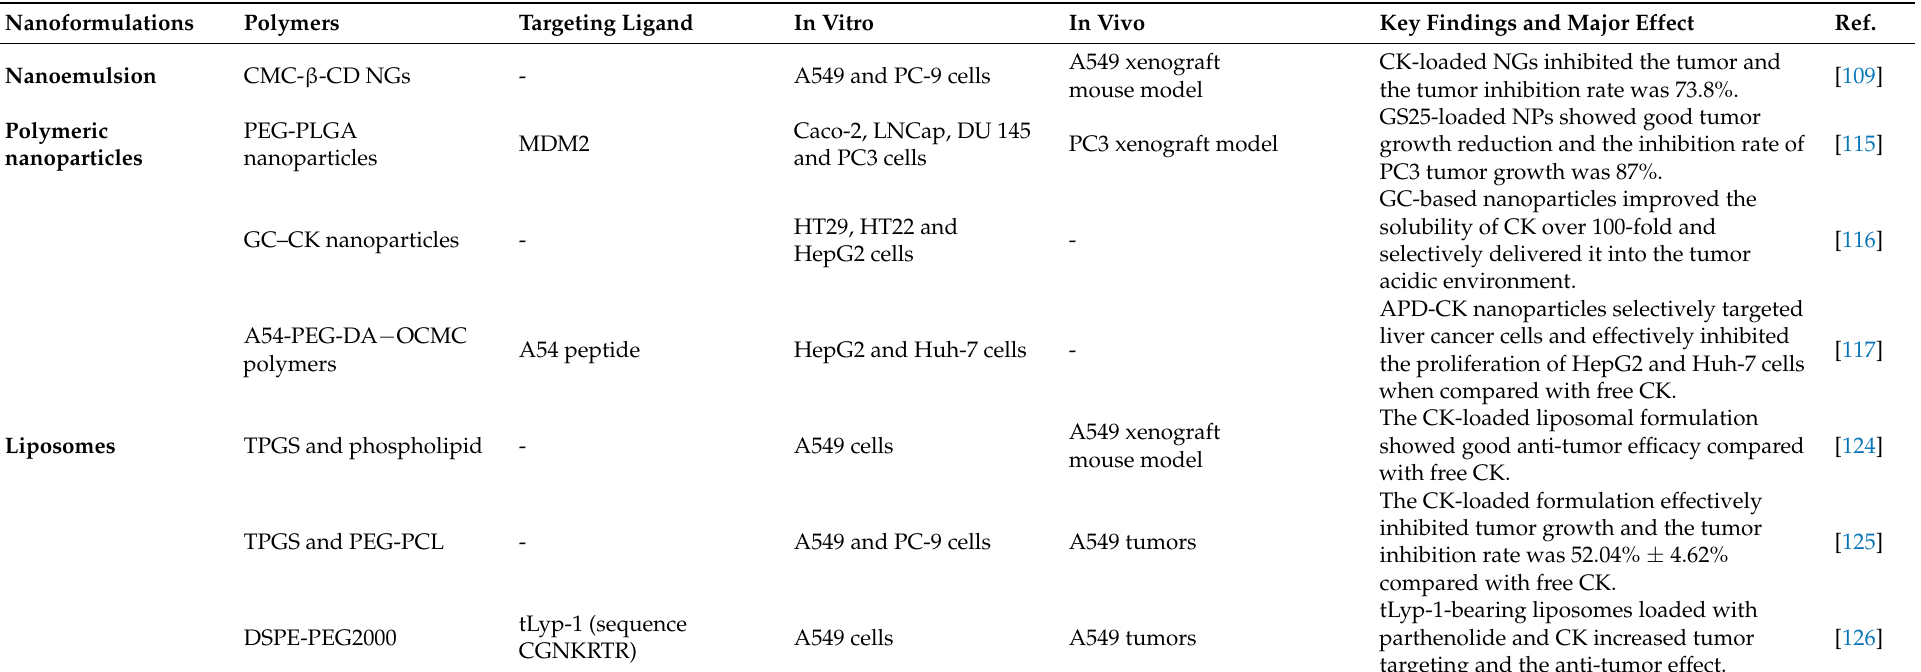
Table 2. CK-loaded nanoformulations for cancer